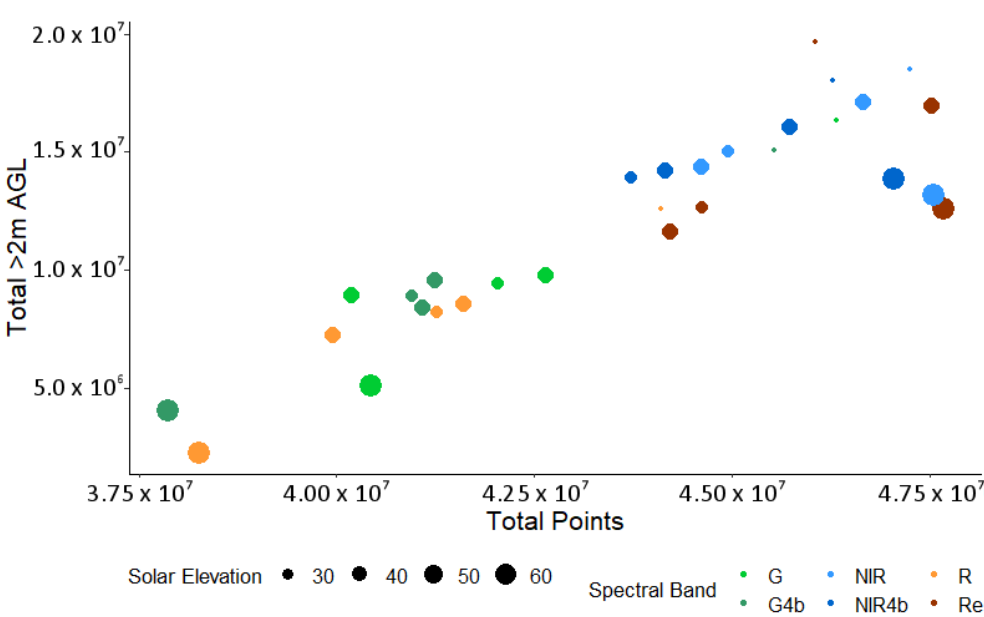
Figure 6. Total dense points in final project compared to total points more than 2 m above ground level (AGL). Processing was conducted for individual cameras (G, green; R, red; NIR, near infrared; red edge, Re) and as a multicamera rig with green (G4b) and NIR (NIR4b). Symbol size is directly related to solar elevation. See specific ranges for each flight in Table